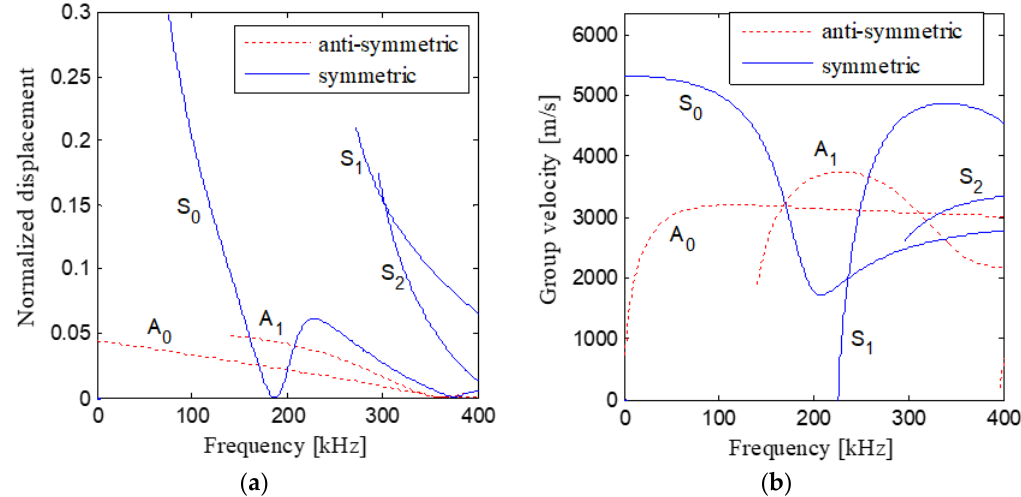
Figure 4. Normalized displacement and group velocity of different modes of Lamb wave excited in the sample: ( a ) Normalized displacement; ( b ) Group velocity.